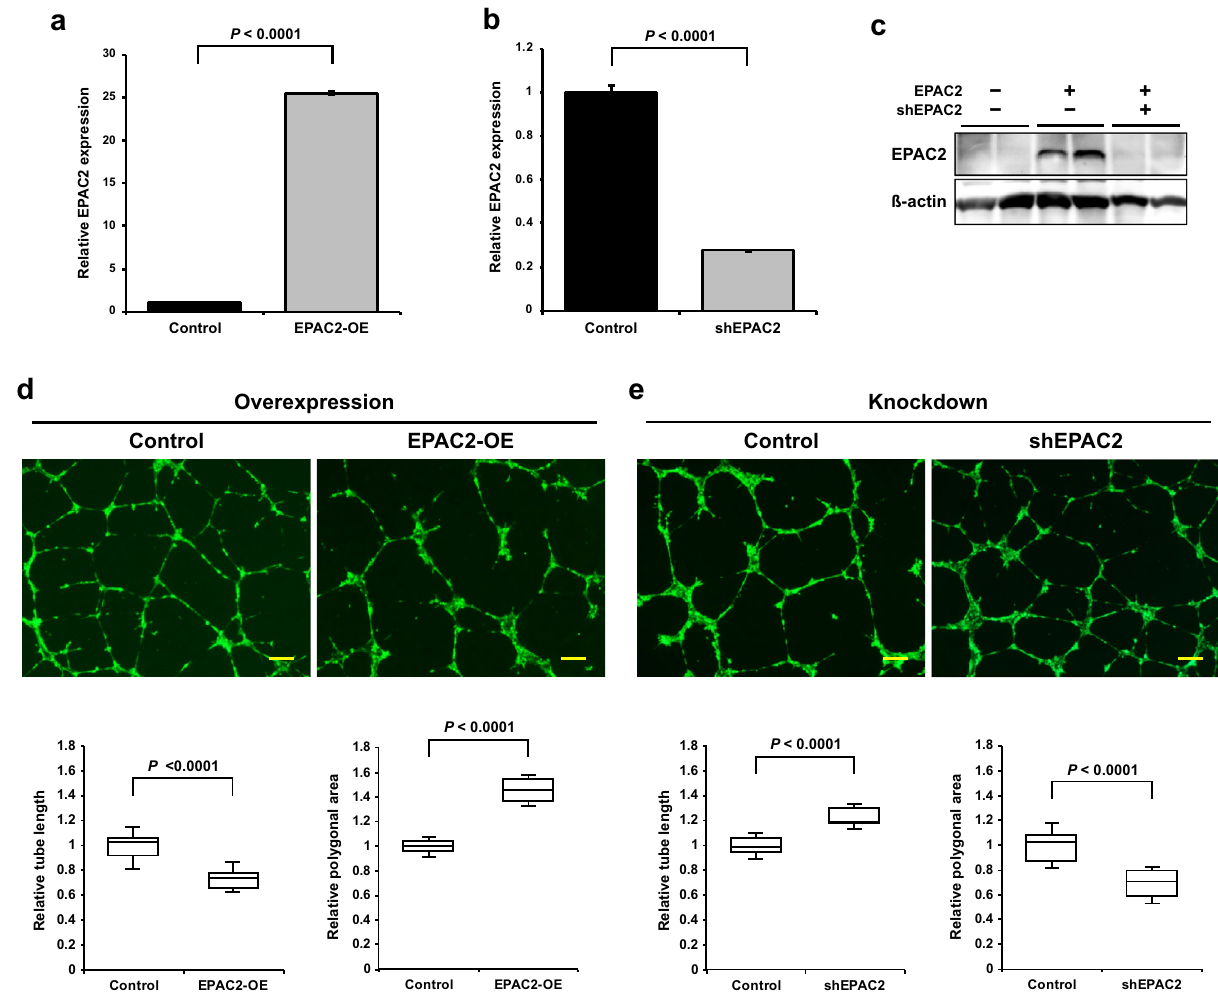
Figure 4. EPAC2 modulates tube formation on Matrigel. ( a,b ) EPAC2 expression in EPAC2 overexpressing ( a ) and knockdown ( b ) TIME cells. Data were expressed as mean ± S.E.M. (n = 3). ( c ) Protein levels of EPAC2 expression. EPAC2 suppression was confirmed in EPAC2 overexpressing HEK293T cells. ( d,e ) Tube formation was suppressed by EPAC2 overexpression ( d ) and facilitated by EPAC2 knockdown ( e ). EPAC2 overexpressing or knockdown TIME cells were cultured on Matrigel in the absence of VEGF, and tube lengths and polygonal areas were analyzed at 8 h as described in the Methods section (n = 10). The box represents the 25–75th percentiles, and the median is indicated. The whiskers show the maximum and minimum values. The same results were obtained in at least three independent experiments. Scale bars: 200 μm. Full-length blots are presented in Supplementary Fig.